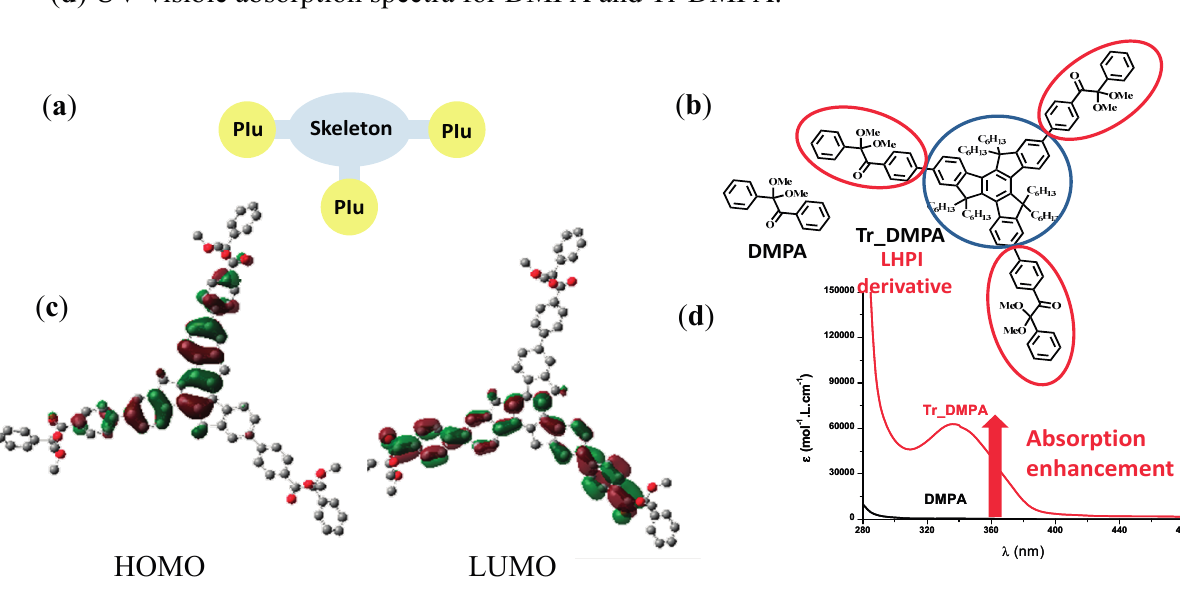
Figure 1. Comparison of the light absorption properties of a LHPI derivative (Tr-DMPA) vs. those of the corresponding DMPA moiety: ( a ) structure for a LHPI derivative; ( b ) chemical formula for DMPA and Tr-DMPA; ( c ) Molecular orbitals for Tr-DMPA and ( d ) UV-visible absorption spectra for DMPA and